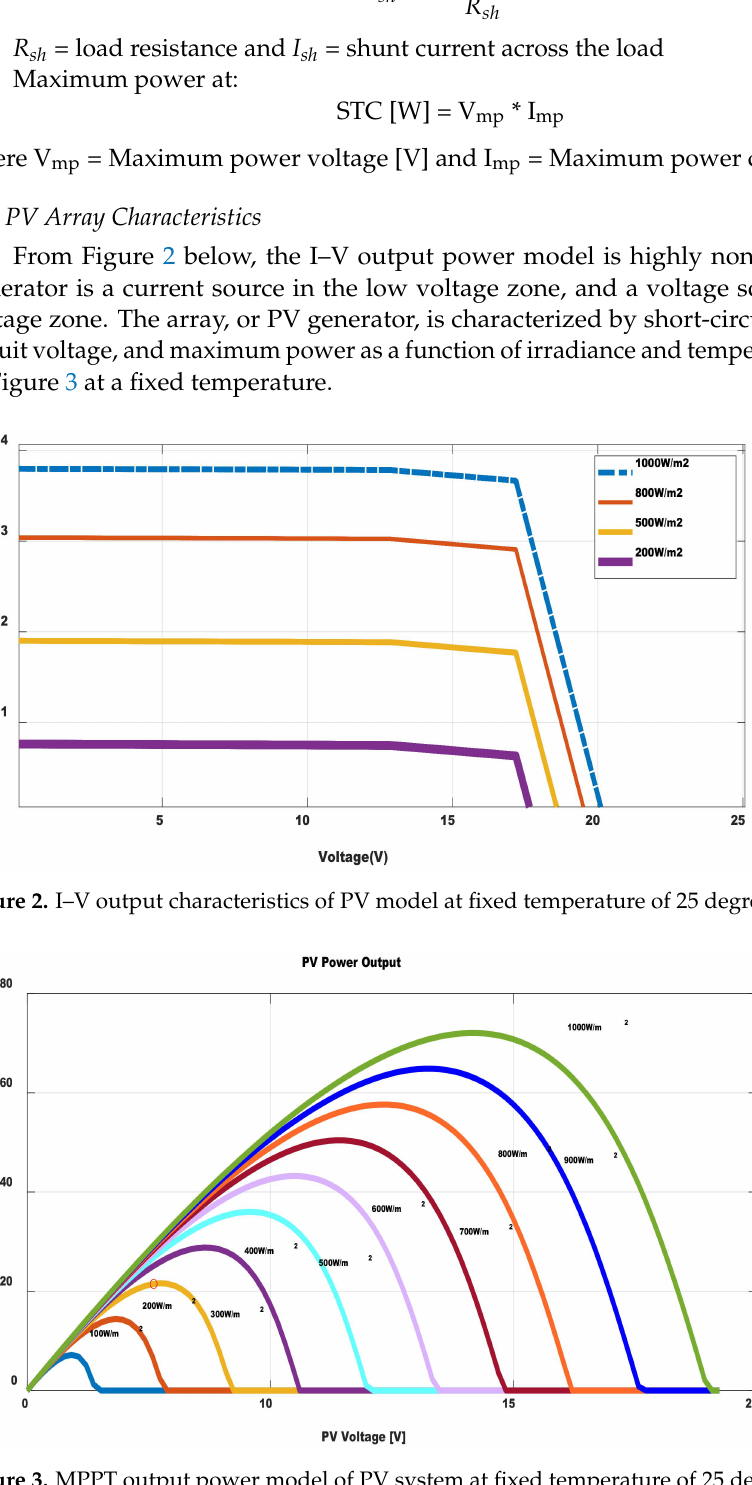
Figure 3. MPPT output power model of PV system at fixed temperature of 25